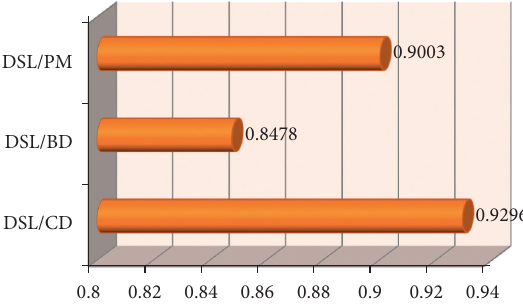
Figure 14: EDR of the briquettes with different binders. Table 5: Comparison of the briquettes with different